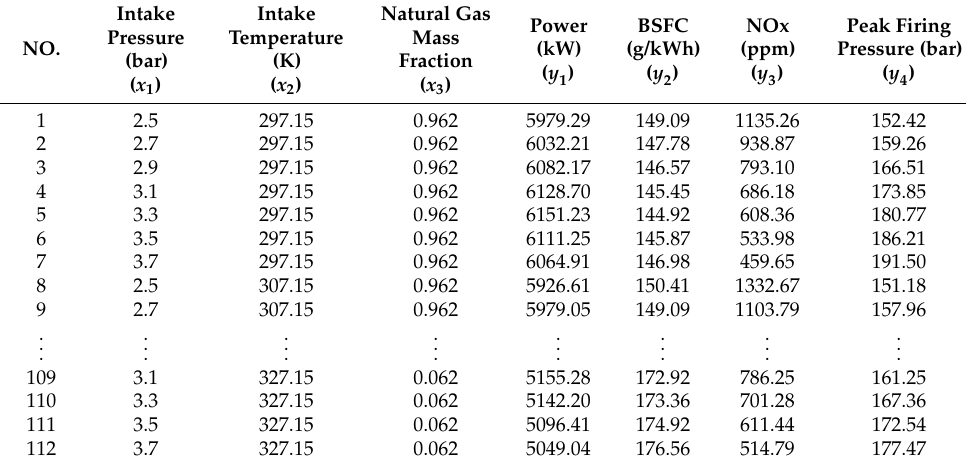
Table 6. The simulation data of DF